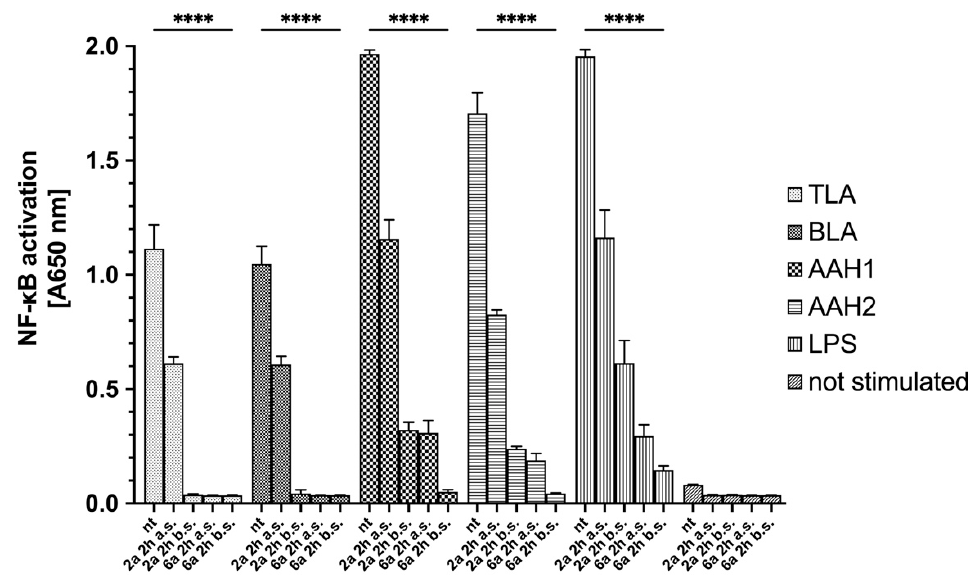
Figure 6. NF- κ B induction in THP1-Blue™ human monocytes exposed to TLA, BLA, AAH1, or AAH2, or treated with LPS (positive control). Data are shown as the means from three repeats with error bars that indicate the standard deviations. Data were compared using a two-way ANOVA test, and for significant comparisons, further analysis was performed using Dunnett’s multiple compar- isons test. Values with statistically significant differences are labeled by asterisks; **** means p < 0.0001. The differences were considered significant with a p value < 0.05 and are presented in Sup-